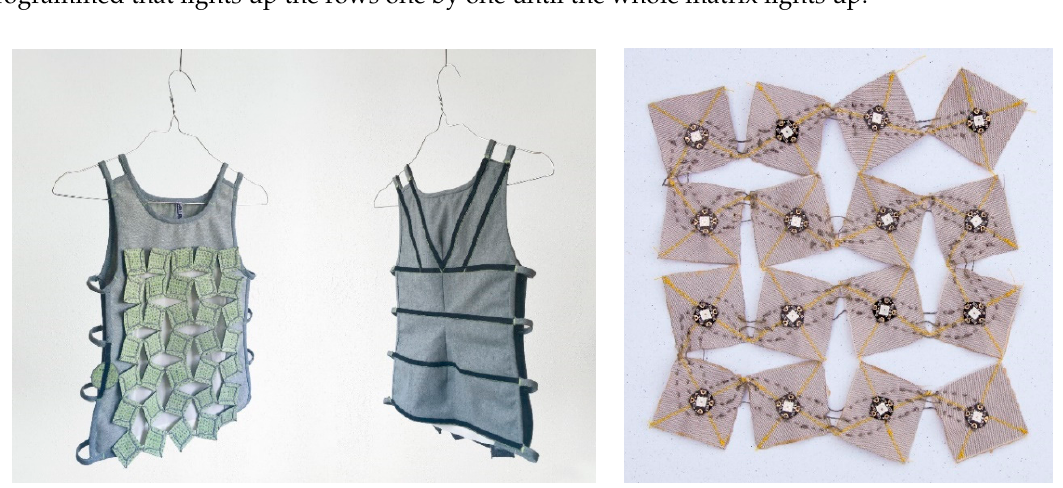
Figure 5. First prototype of the Wearable Breathing Trainer (WBT) with the square-shaped robotic textile and the LED-matrix.